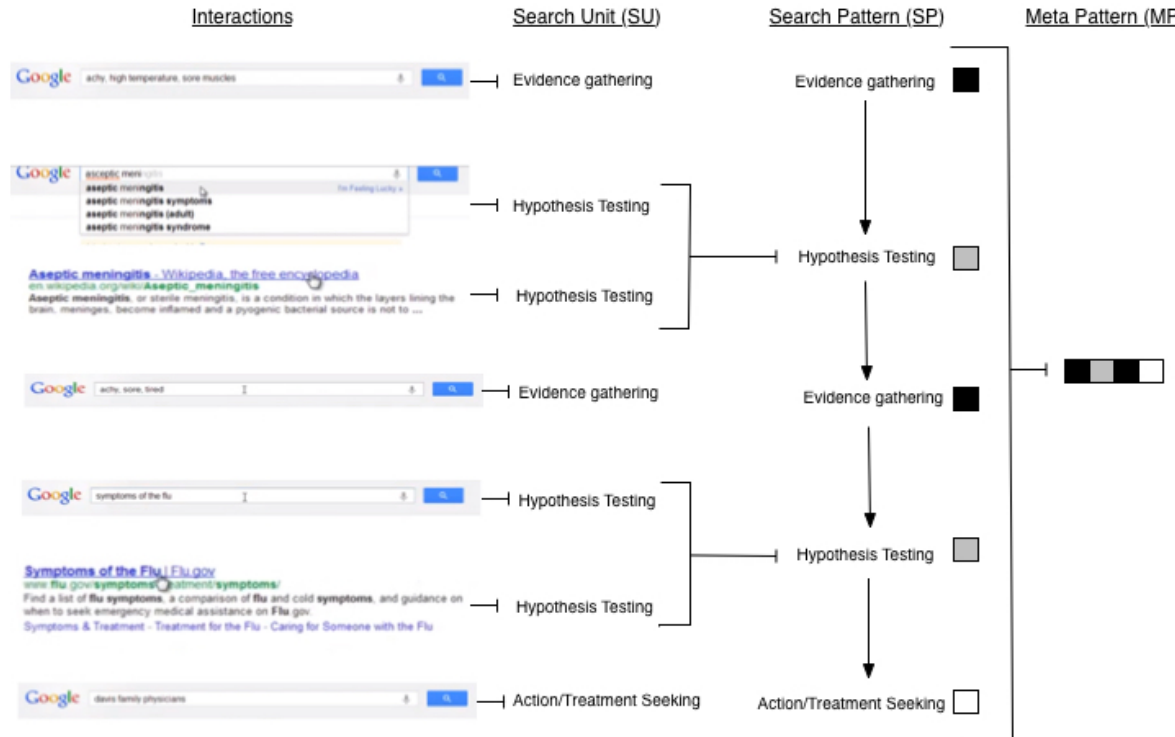
Figure 2. Example of coding process from interaction to